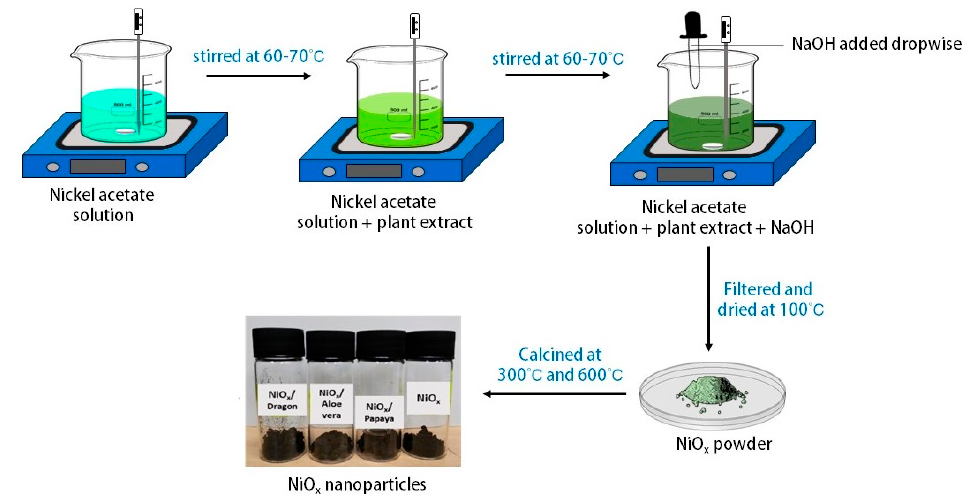
Figure 10. Reaction scheme for green synthesis process of NiOx